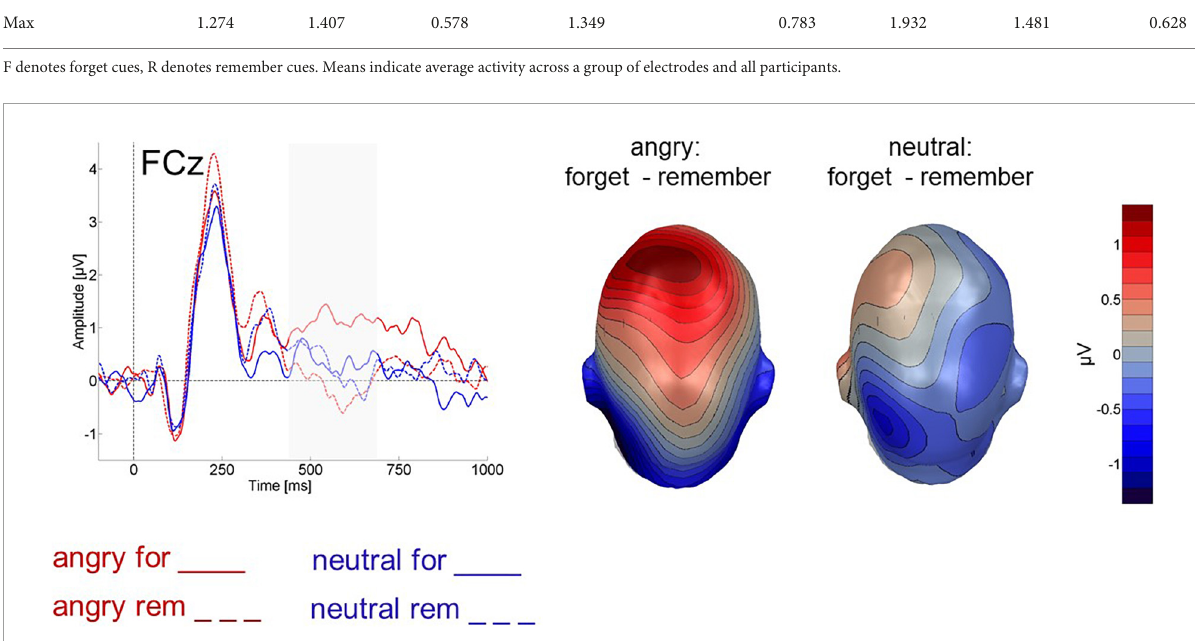
FIGURE6 Cue-evoked ERP for cues following angry (red) and neutral (blue) faces at fronto-central electrode FCz. Forget cues are solid lines, remember cues are dashed. Right panel shows difference topographies for forget minus remember cues, separately for cues following angry and neutral faces, across all 64 electrodes between 450 and 700 ms after cue